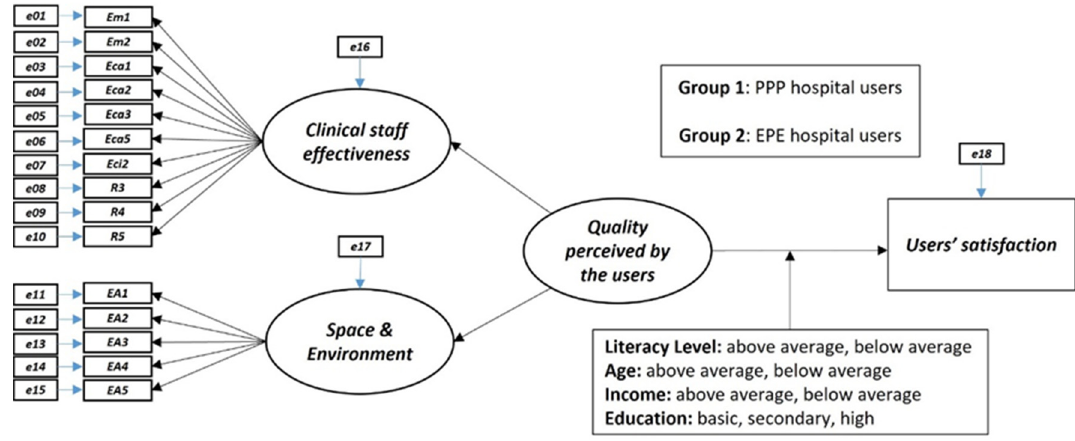
Figure 1. Path diagram of the model.